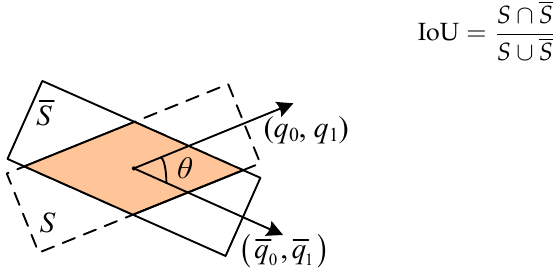
Figure 7. A schematic diagram of calculating the ground truth.